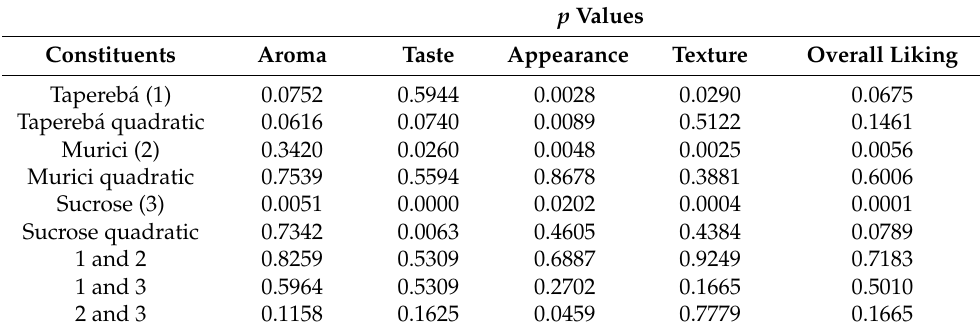
Table 4. Values of p for sensorial acceptance for murici and tapereb á blend beverage.